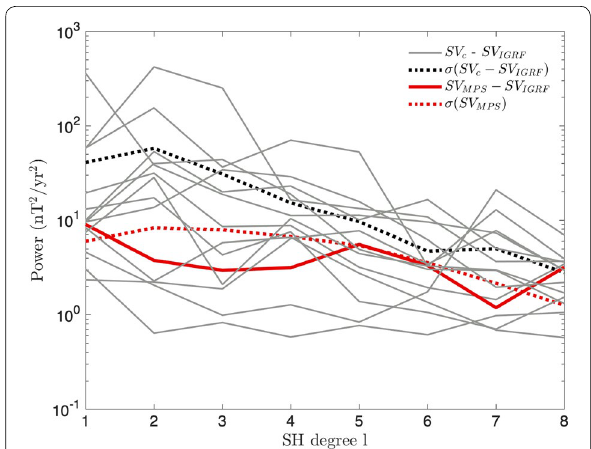
Fig. 8 Mauersberger–Lowes power spectra of the differences between each of the other 13 SV model candidates and the IGRF-13 (gray curves) as well as the dispersion of all the candidate models around the latter (dashed black curve). The difference between our candidate model and IGRF-13 and its corresponding uncertainty given by the spread of the ensemble (red solid and dashed curves, respectively), are also